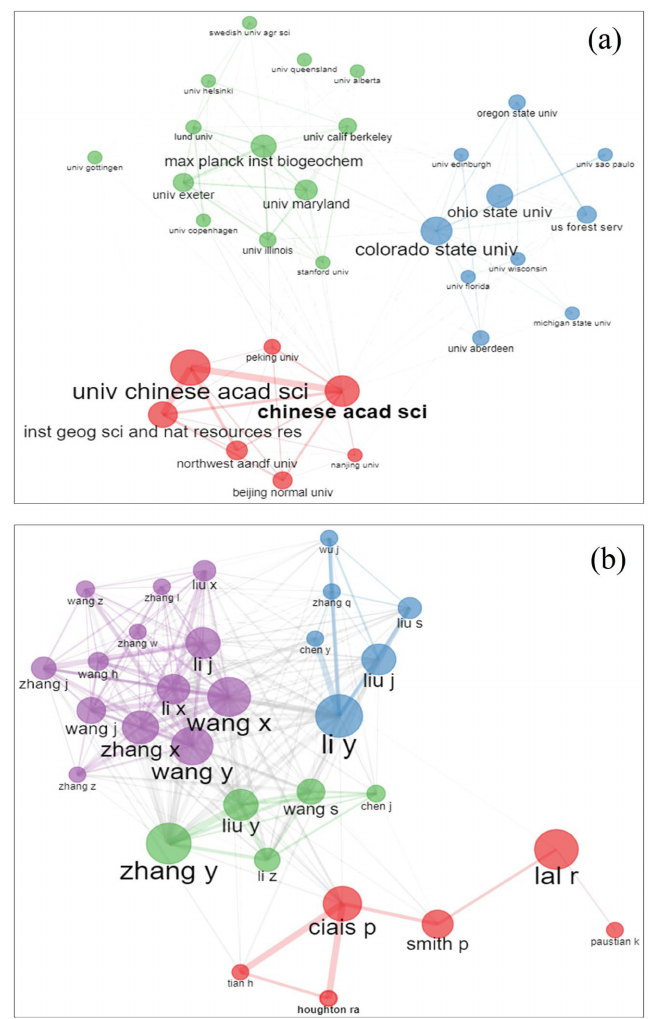
Figure 5. ( a ) Inter-Institutional Cooperation, and ( b ) Inter-Author Cooperation, in the Field of Effects of Land Use Change on Soil Carbon Sequestration from 1985 to 2021. The colored circles in the figure represent different cooperative network relationships and the larger the circle is, the more papers published by the research institution or scholar will